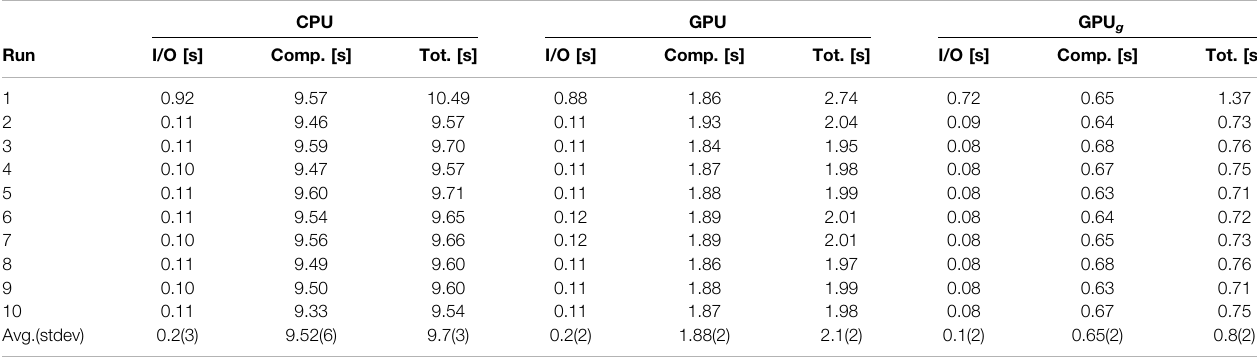
TABLE A1 | Breakdown of the Event Loop time (Tot.) into I/O time (I/O) and compute time (Comp.) for the simulation of Photons with E (cid:2) 32 . 768 GeV and η min (cid:2) 0 . 2, corresponding to the 5th row in Table 1 . CPU GPU GPU g